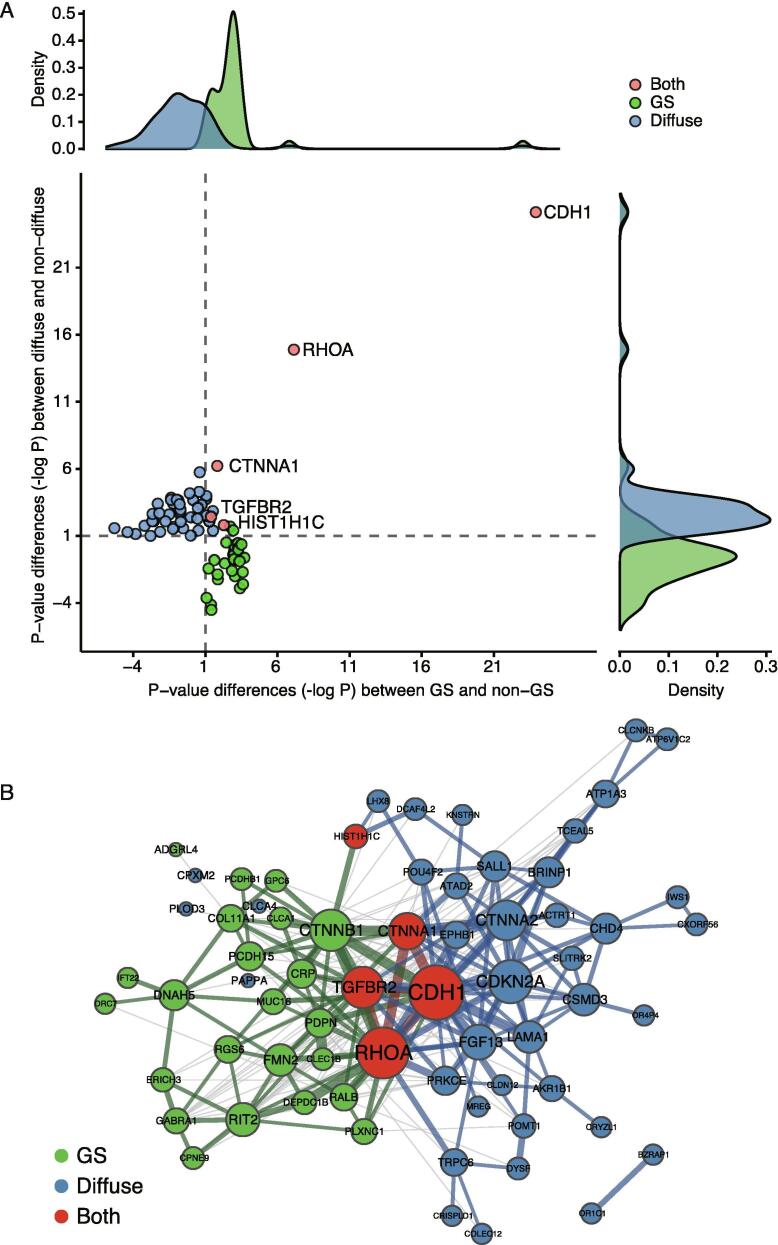
Distribution of differences between P-values in the diffuse type and GS subtype. (A) Scatter plot of P-value differences in the diffuse type and GS subtype. All P-values were transformed to negative log10 P-value. (B) Molecular interaction network of genes with P-value differences in the diffuse type and GS subtype. Circle size represents the number of interactions for each gene and width of an edge indicates the score as defined in the STRING database. Genes showing 10-fold P-value differences in the diffuse type and GS subtype are shown in green and blue, respectively. Red circles indicate the common significantly mutated genes in both subtypes. Blue and green edges indicate an in-edge linked in the diffuse type and GS subtype, and a gray edge indicates an inter-edge between these types. (For interpretation of the references to colour in this figure legend, the reader is referred to the web version of this article.)